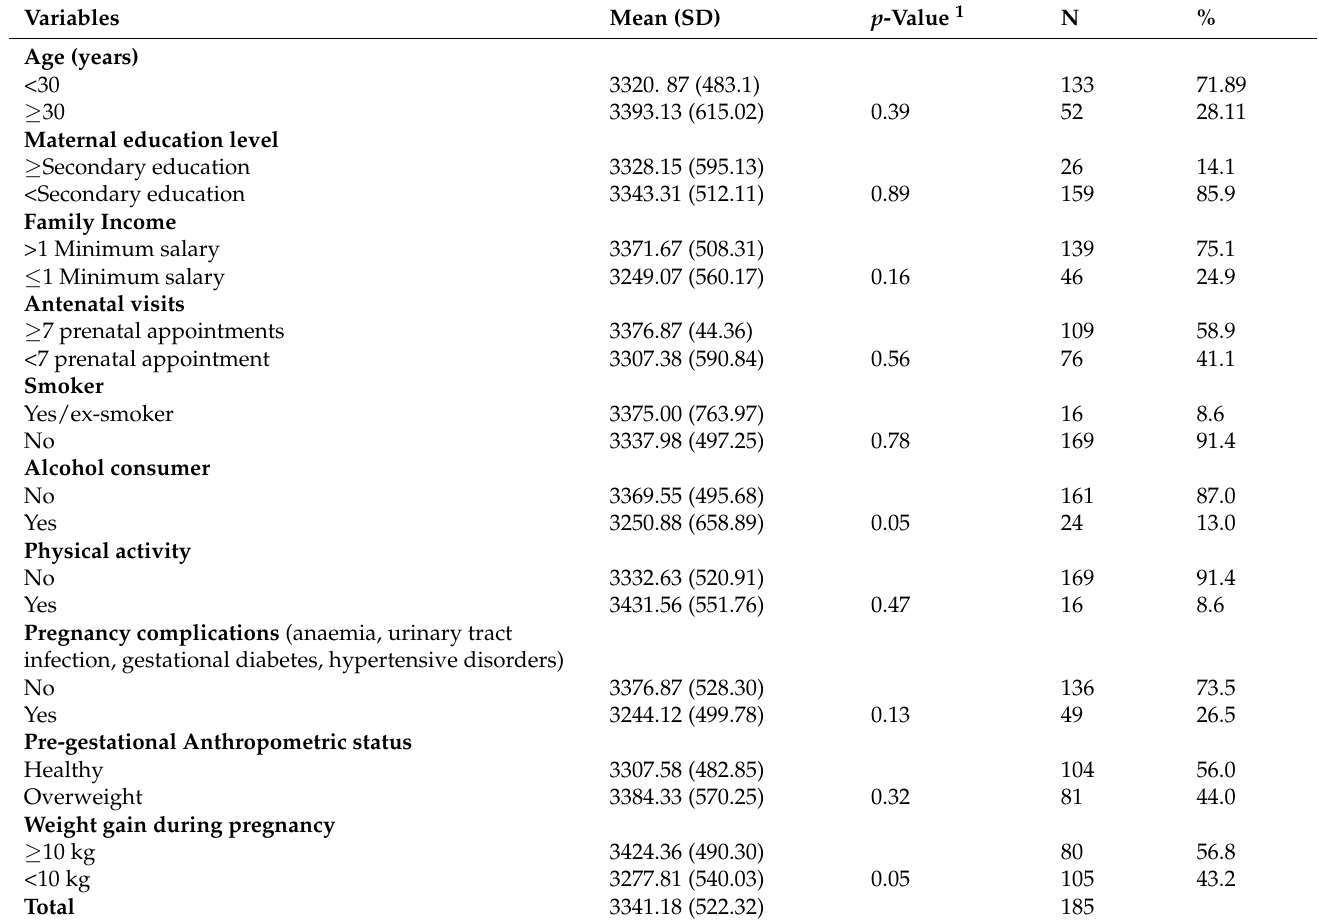
Table 1. Mean of birth weight according to sociodemographic, biological, and anthropometric characteristics of mothers and their children, Santo Ant ô nio de Jesus, Bahia, Brazil,